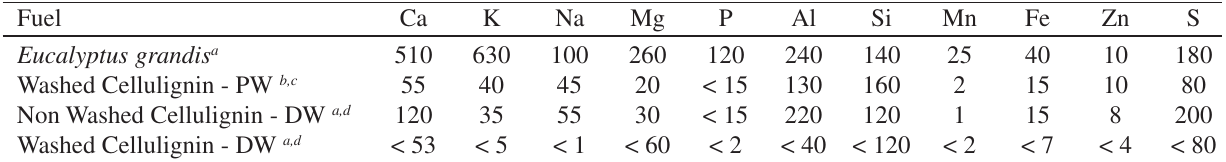
Table 1. Inorganic constituent concentrations of the Eucalyptus grandis wood and cellulignin produced from the wood (mg/g).